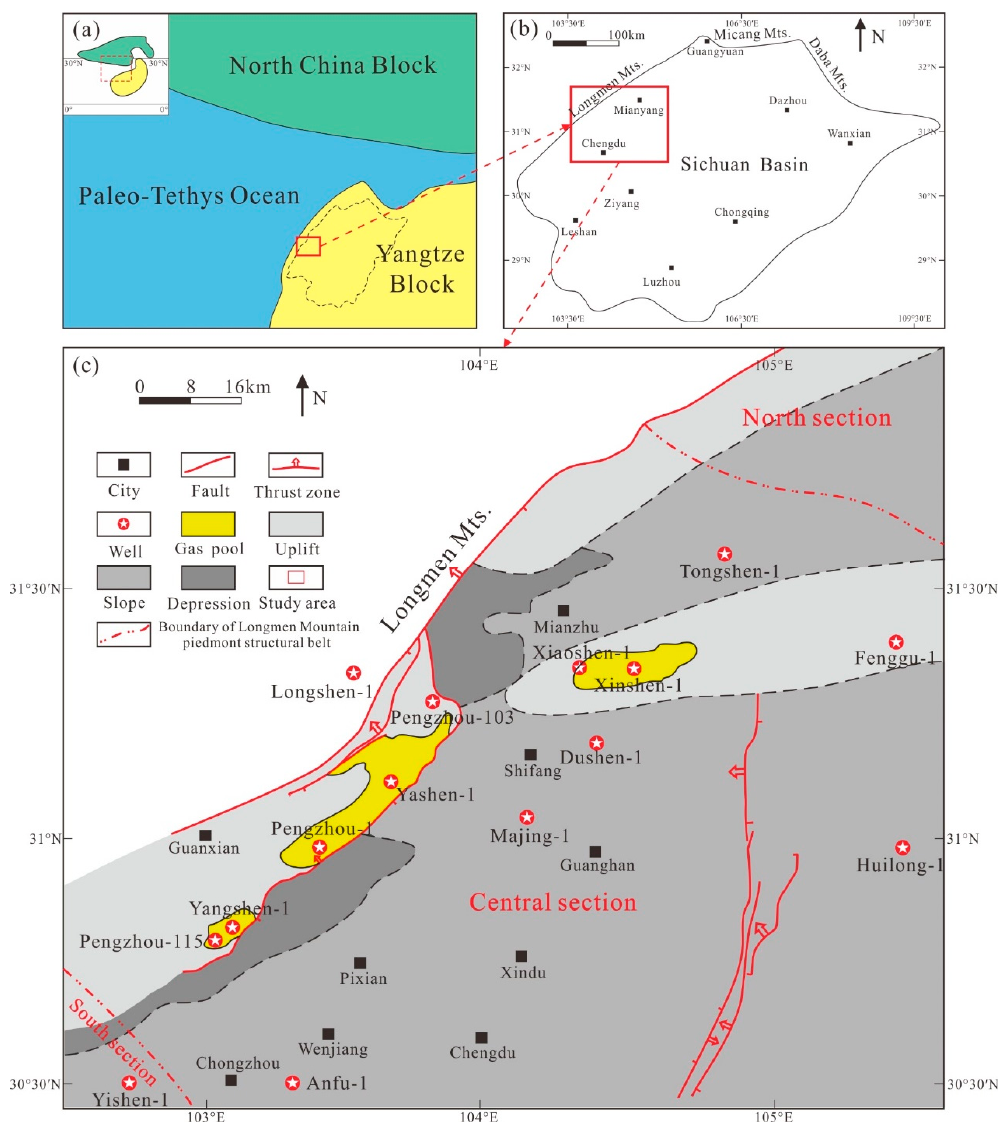
Figure 1. ( a ). The location of the study area in Middle Triassic. ( b ). The location of the study area in modern times. ( c ). The present tectonic units and representative wells of the study area (modified from [48]).